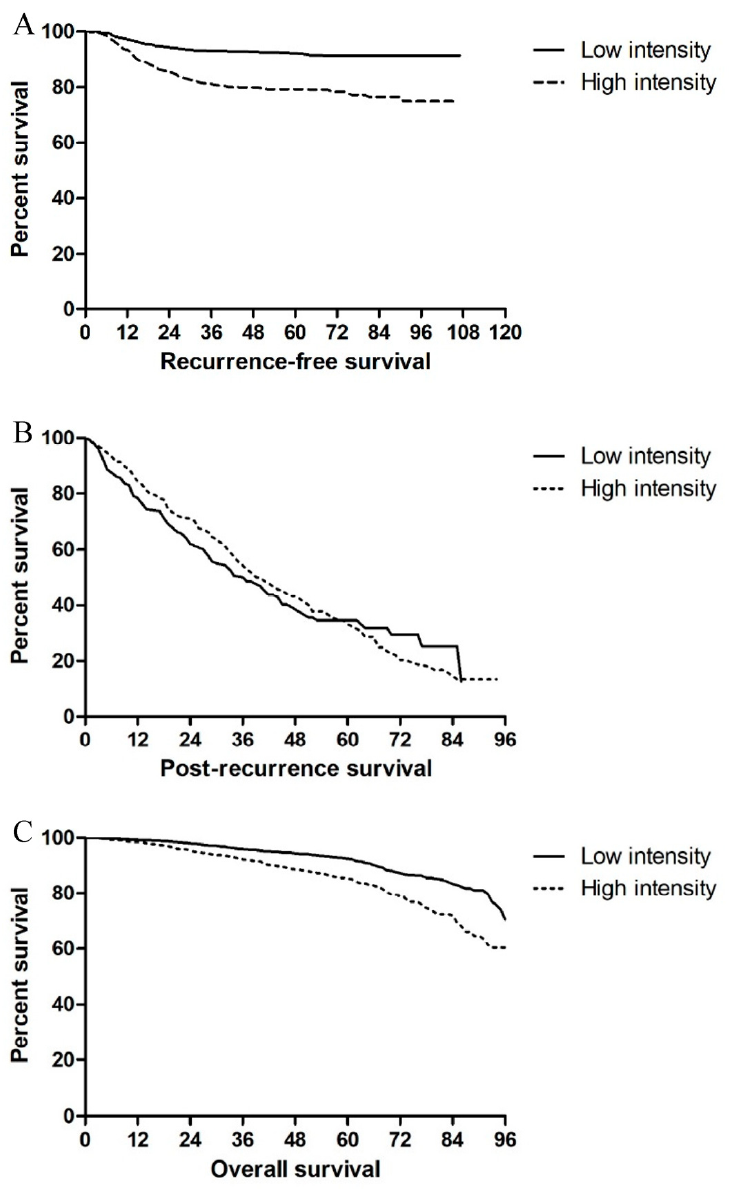
Figure 1. Kaplan–Meier analyses of ( A ) recurrence-free survival, ( B ) post-recurrence survival, and ( C ) overall survival according to surveillance intensity. Abbreviations: LI, low surveillance intensity; HI, high surveillance intensity; LR, low-recurrence risk; HR, high-recurrence risk. When subgroup analysis was performed according to the stage, the higher the stage, the higher the percentage of patients in the HI group. In addition, the recurrence rate was high in the HI group regardless of stage, but such a high recurrence rate tended not to affect the survival improvement (Table